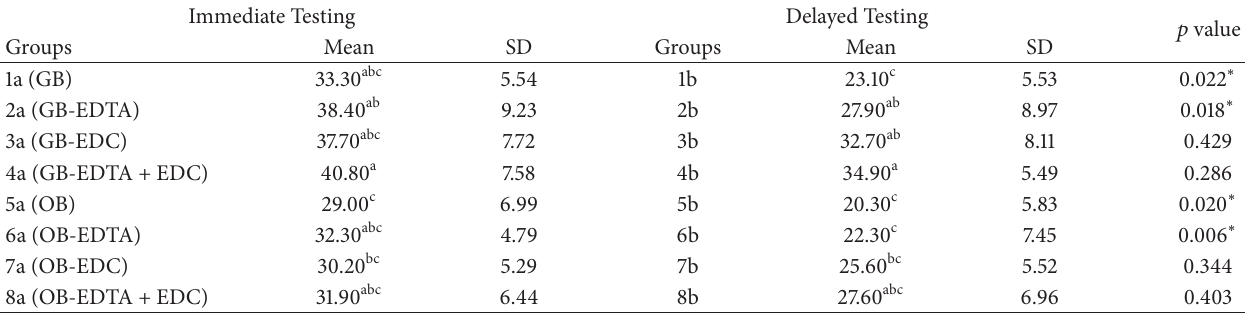
Table 1: Mean shear bond strength values both immediate and delayed for G-Bond and OptiBond-All-In-One adhesives. Immediate Testing